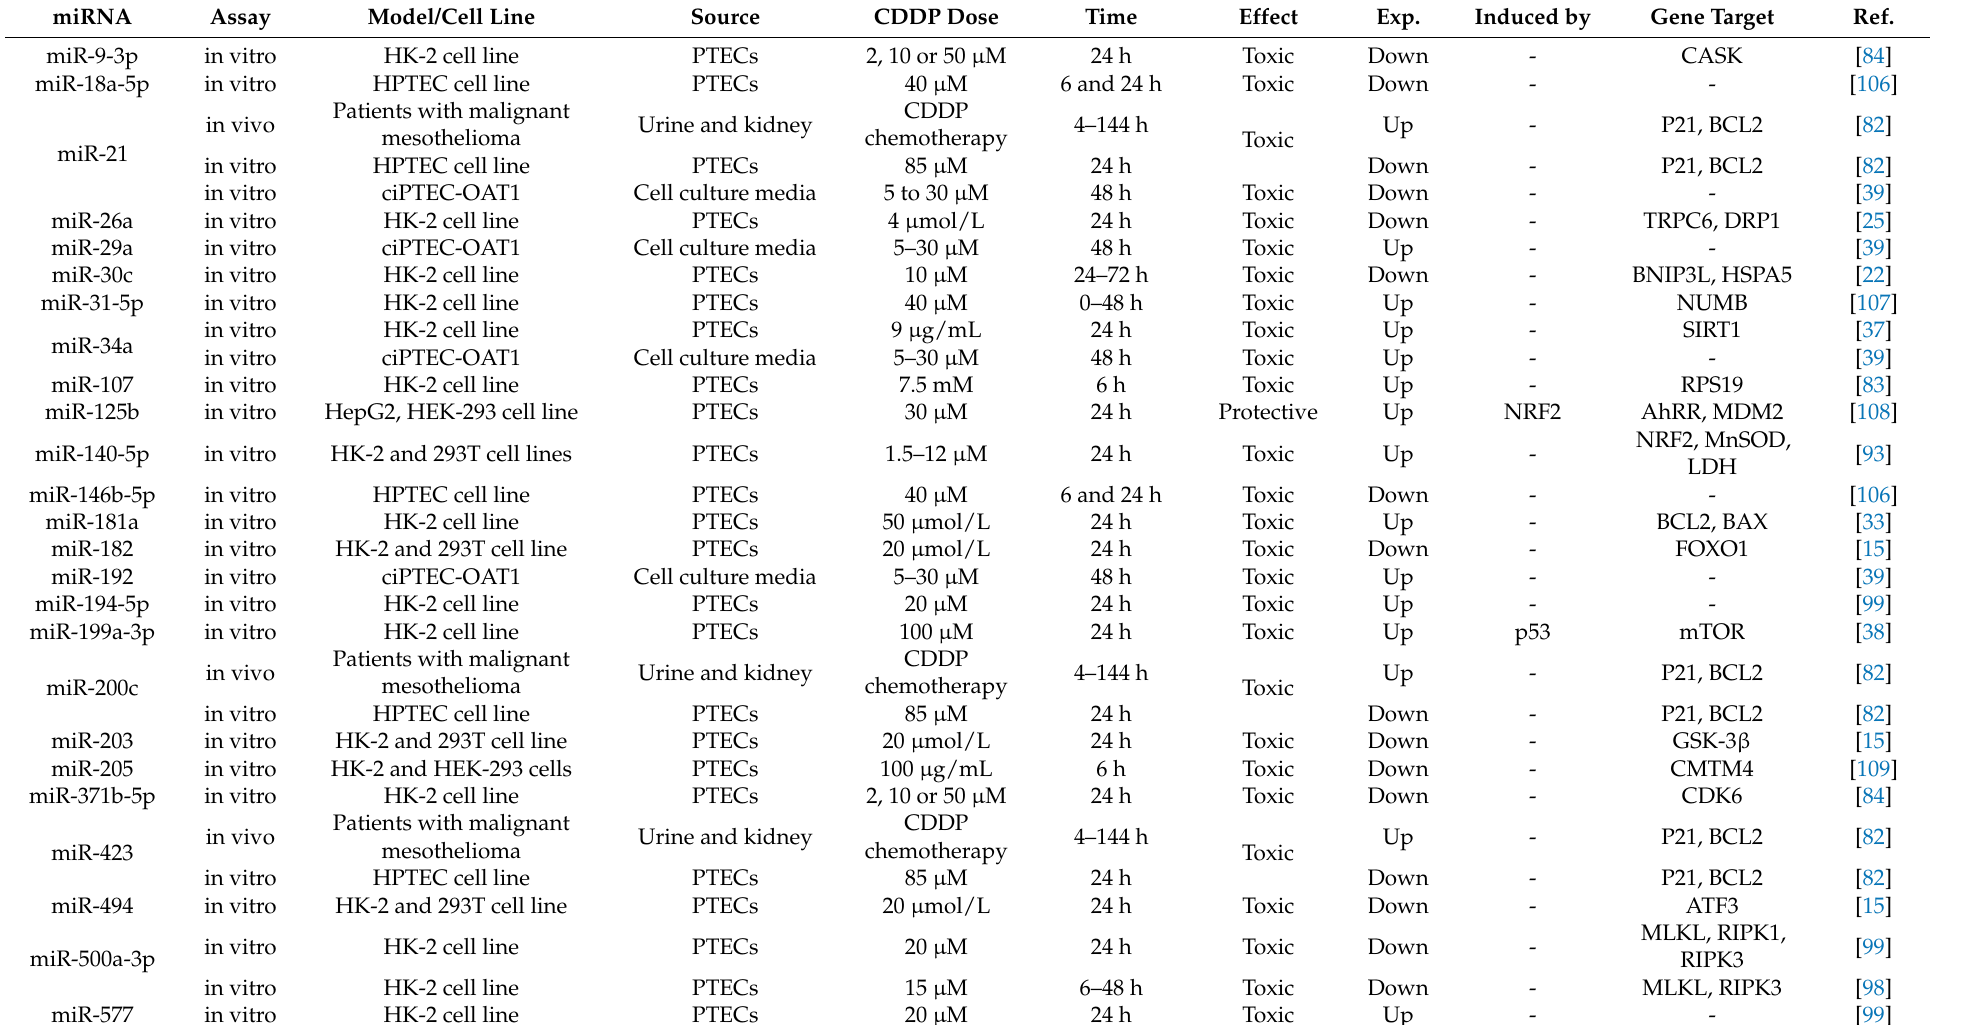
Table 1. In vitro and in vivo evidence of microRNAs involved in cisplatin-induced nephrotoxicity in